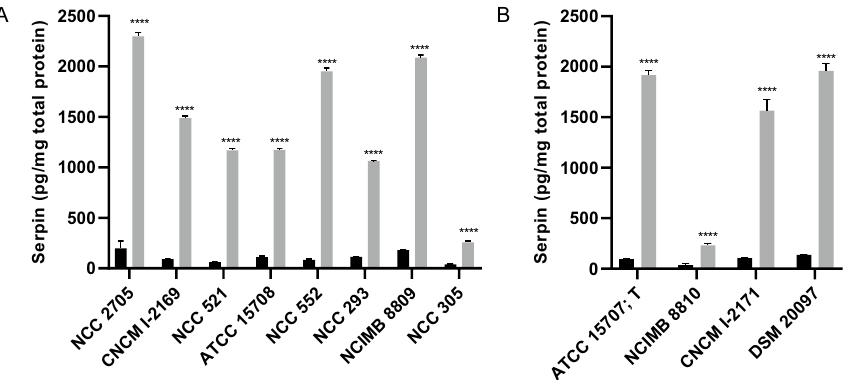
Figure 4. Serpin protein concentration in a set of B. longum subsp. longum strains grown for 16 h on MRSc medium supplemented with 1% glucose (black bars) or 1% galactose (grey bars). Bars represent means and standard deviations are shown. Panel A depicts B. longum subsp. longum strains able to rapidly grow on galactose as a sole carbon source). Panel B displays B. longum subp. longum strains not able to rapidly switch to galactose as a sole carbon source. These strains were grown on a medium supplemented with 1% glucose (black bars) or with a mixture of 0.2% glucose and 0.8% galactose (grey bars). P -values represent statistical difference to the glucose control groups. **** p <